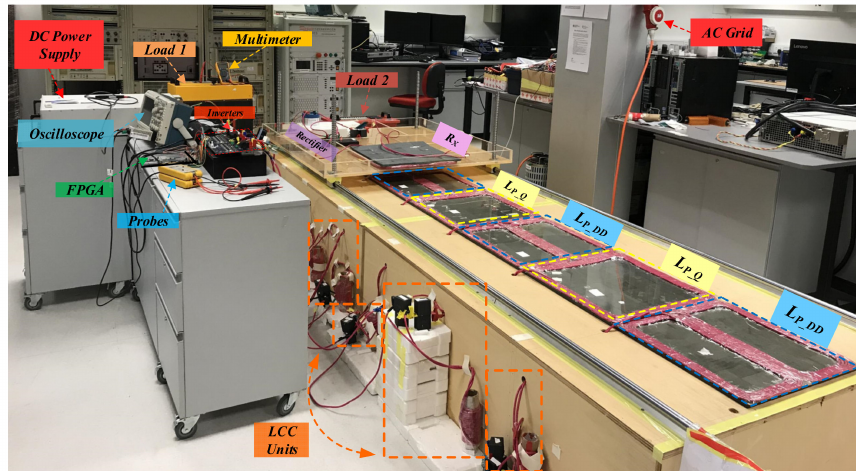
Figure 11. The experimental prototype.